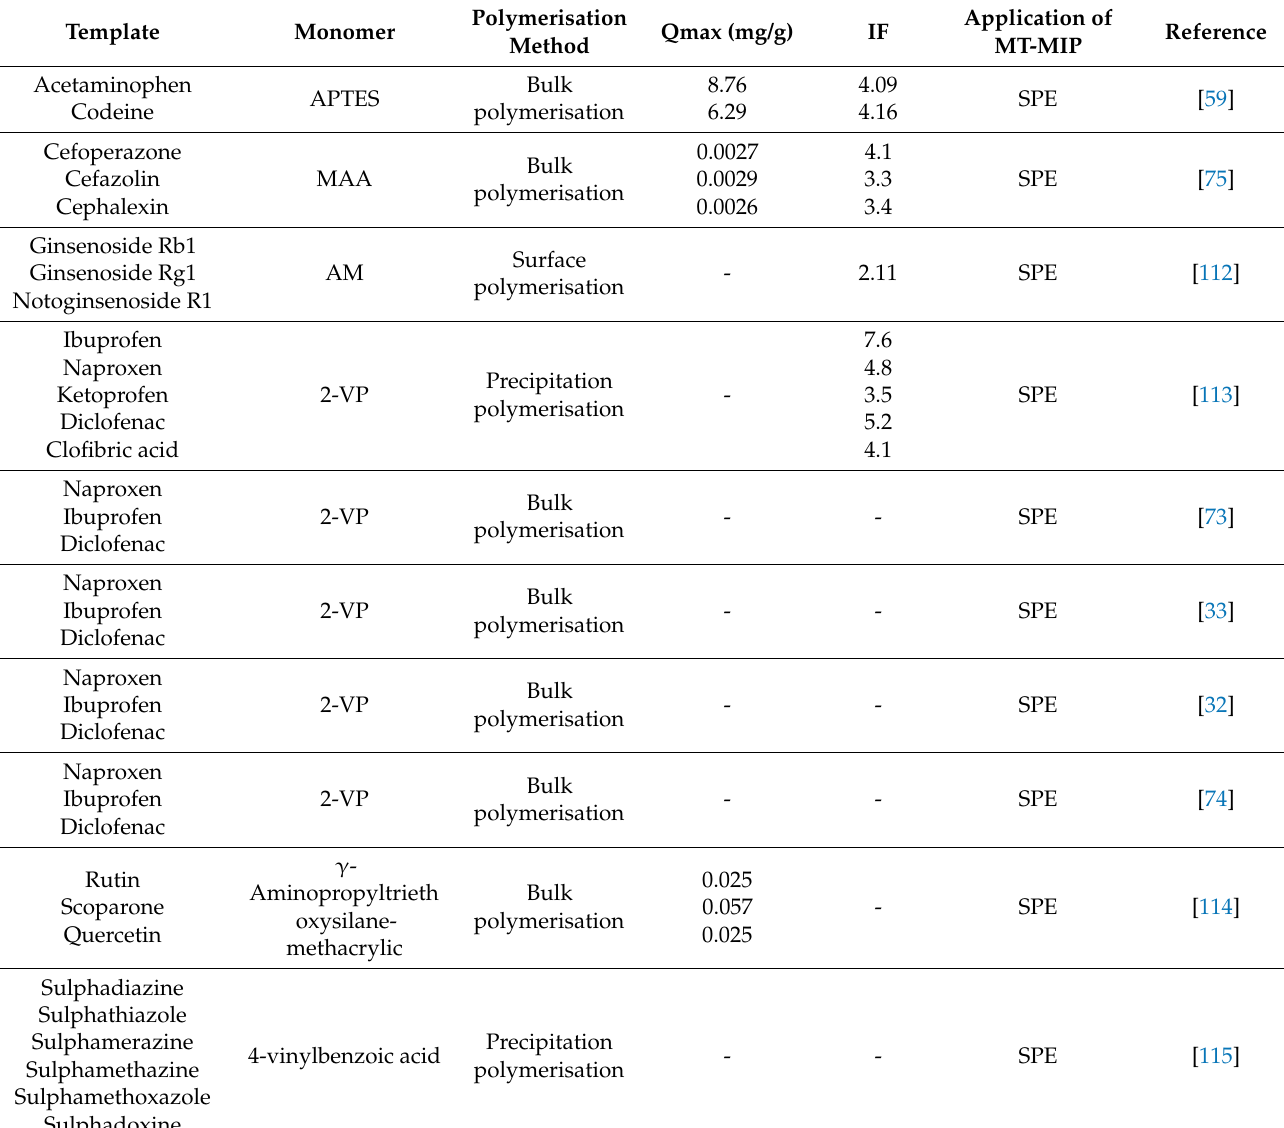
Table 3. Drugs used as templates in multi-template molecularly imprinted